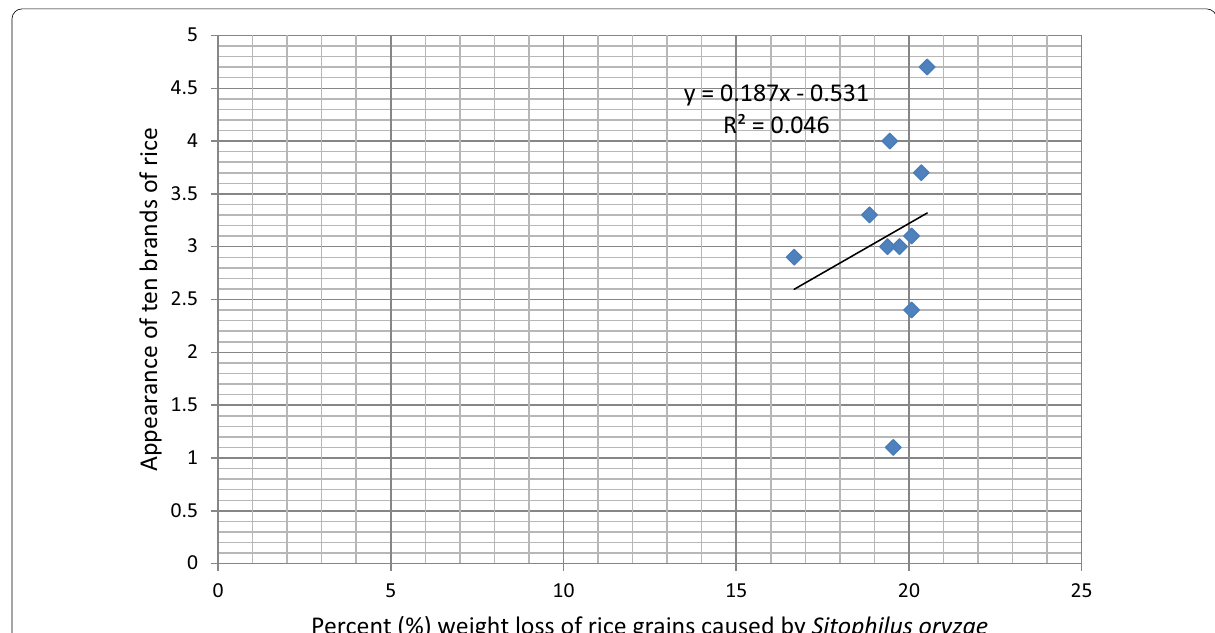
Fig. 5 Association between rice brand appearance and grain weight loss caused by Sitophilus